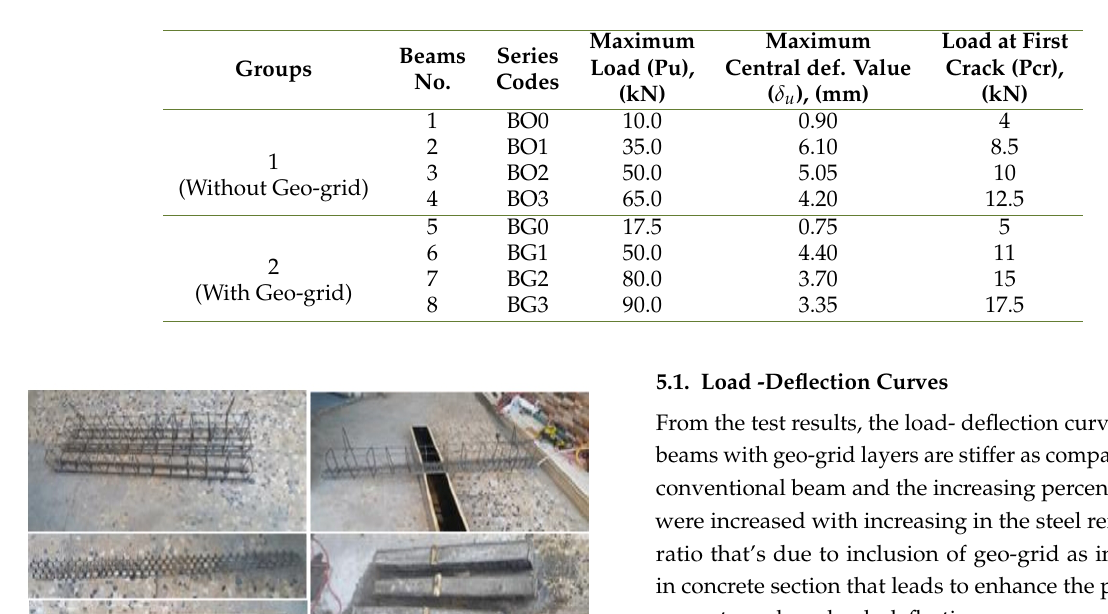
Table 4. Test Results